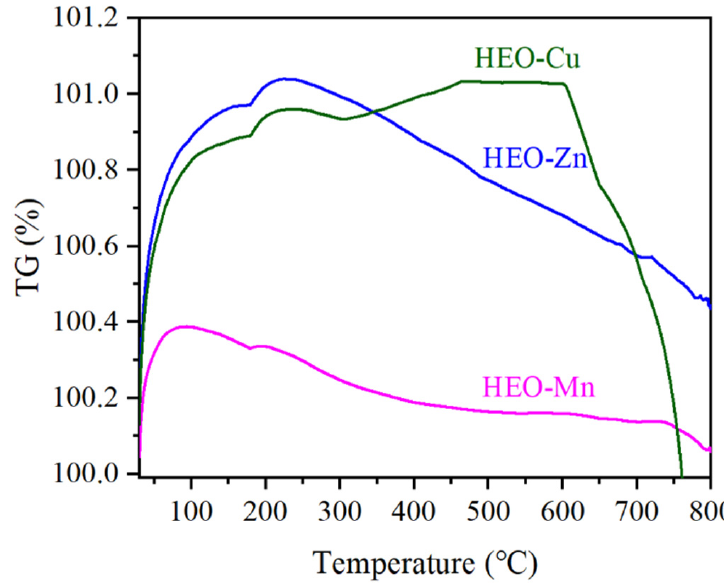
Figure 6. DTG curves of HEO − Zn, HEO − Cu, and HEO − Mn samples.